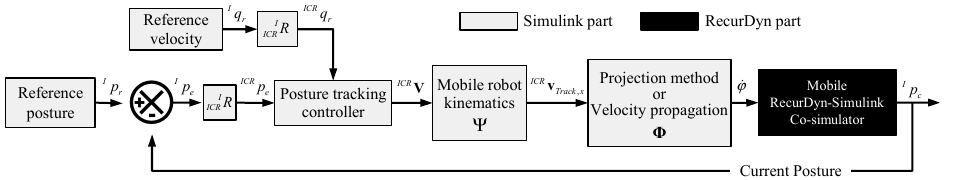
Figure 6. Posture error for the posture tracking controller.